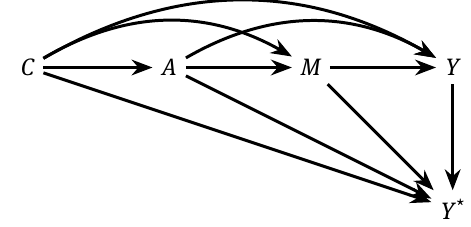
Figure 3: Differential misclassification in the measurement of outcome Y * in mediation analysis